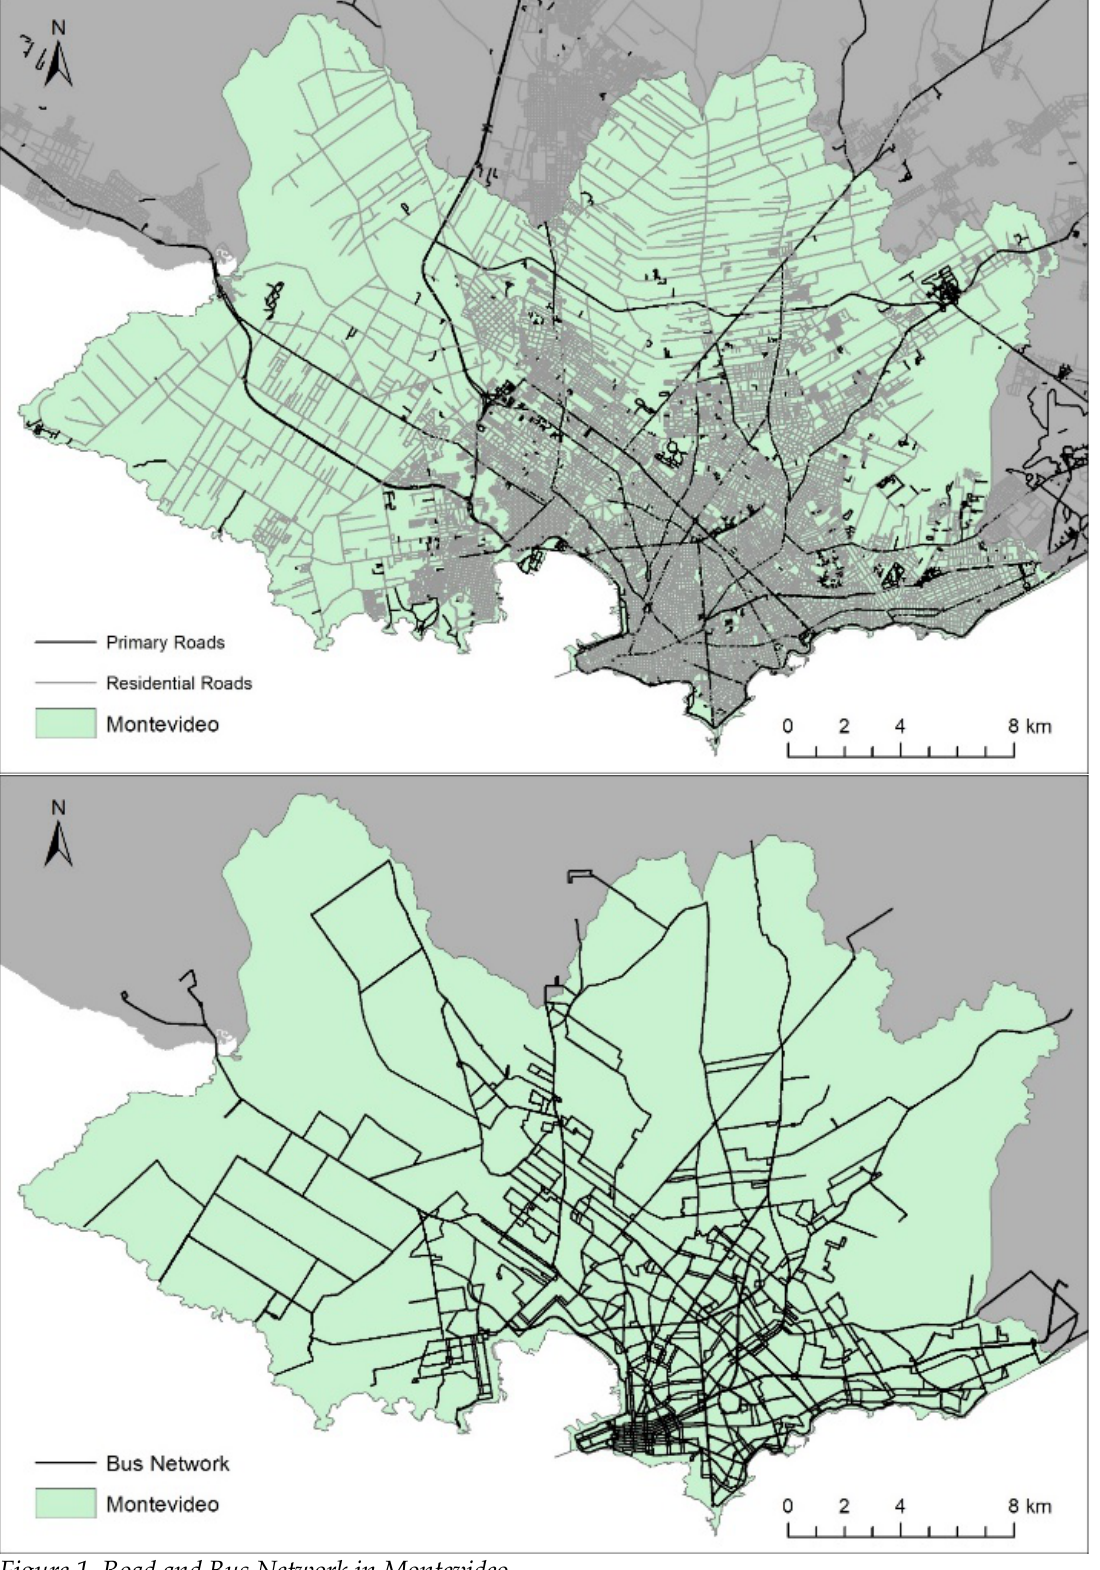
Figure 1. Road and Bus Network in